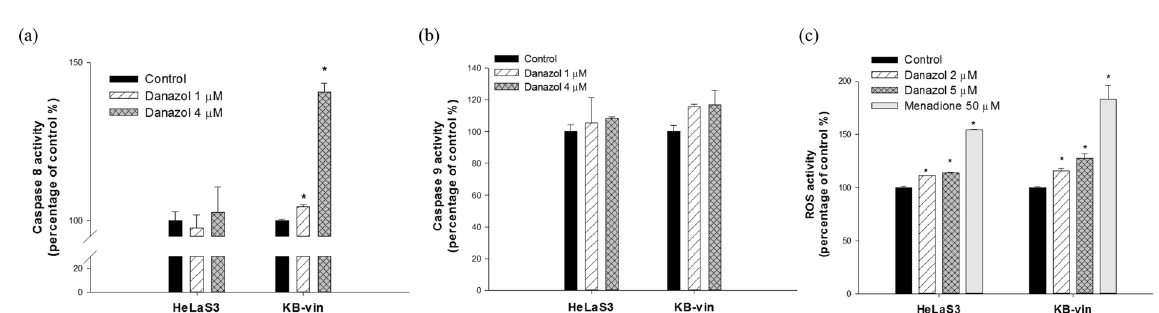
Figure 5. Results of caspase activity and ROS levels detection assay in HeLaS3 and MDR KB/VIN cells. HeLaS3 and KB/VIN cells were treated with or without danazol for 72 hours. The activities of caspase-8 ( a ) and caspase-9 ( b ) were evaluated by Cell Meter ™ Caspase Activity Apoptosis Assay Kits. Danazol activated caspase-8 in KB/VIN cells while the level remained the same in HeLaS3 cells compared with respective control group. ( c ) The treatment of danazol increased the ROS level in both HeLaS3 and KB/VIN cell lines. Menadione, a ROS inducer, was used as a positive control. Statistical differences were evaluated by the ANOVA followed post hoc analysis (Tukey’s test). * indicates p value < 0.05 compared with control group. Data presented as mean ± SE of at least two experiments, each in